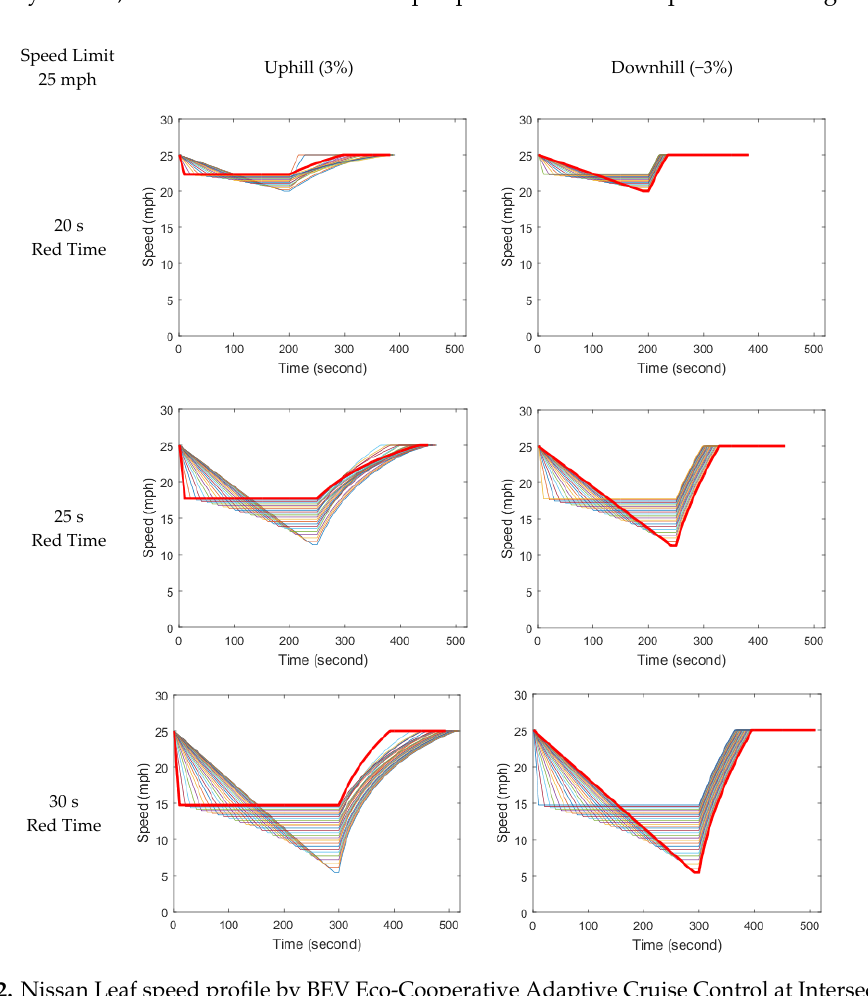
Figure 2. Nissan Leaf speed profile by BEV Eco ‐ Cooperative Adaptive Cruise Control at Intersections (BEV Eco ‐ CACC ‐ I) for a speed limit of 25 mph.